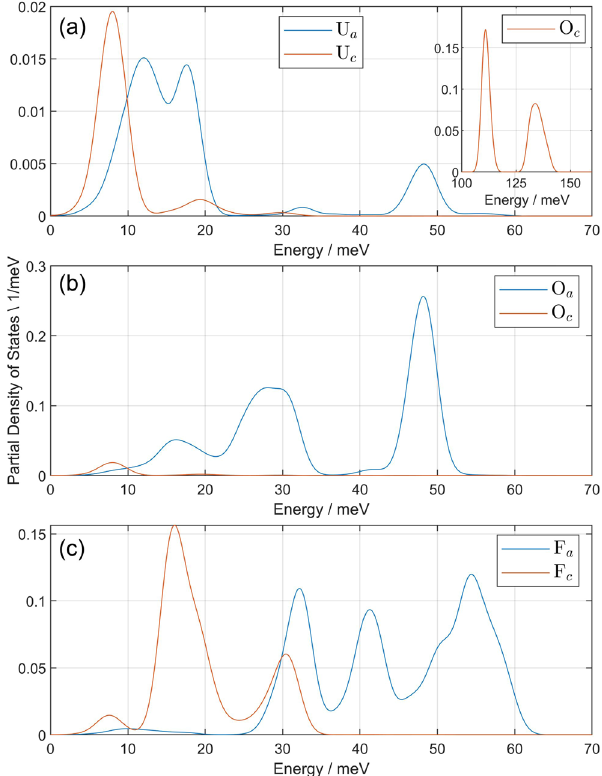
Figure 4. Neutron-weighted density of states projected onto the hexagonal a / b and c axes for U atoms ( a ), O atoms ( b ), and F atoms ( c ). Inset in panel (a) shows density of O atom states projected onto c axis for the uranyl stretching region. No fluorine motion is observed in the uranyl stretching region. Uranium motion is primarily restricted to the low energy modes, with exceptions for a bending mode at 48 meV and small contribution to the asymmetric uranyl stretching mode at 133 meV. Due to its large mass, the U atoms contribute little to the full gdos in Fig. 3. Oxygen atoms are distinctly polarized along a / b below 60 meV and along c above 100 meV. Fluorine atoms show the opposite behavior, polarized along c at lower energies, but no F motion participates in phonons above 65 meV.